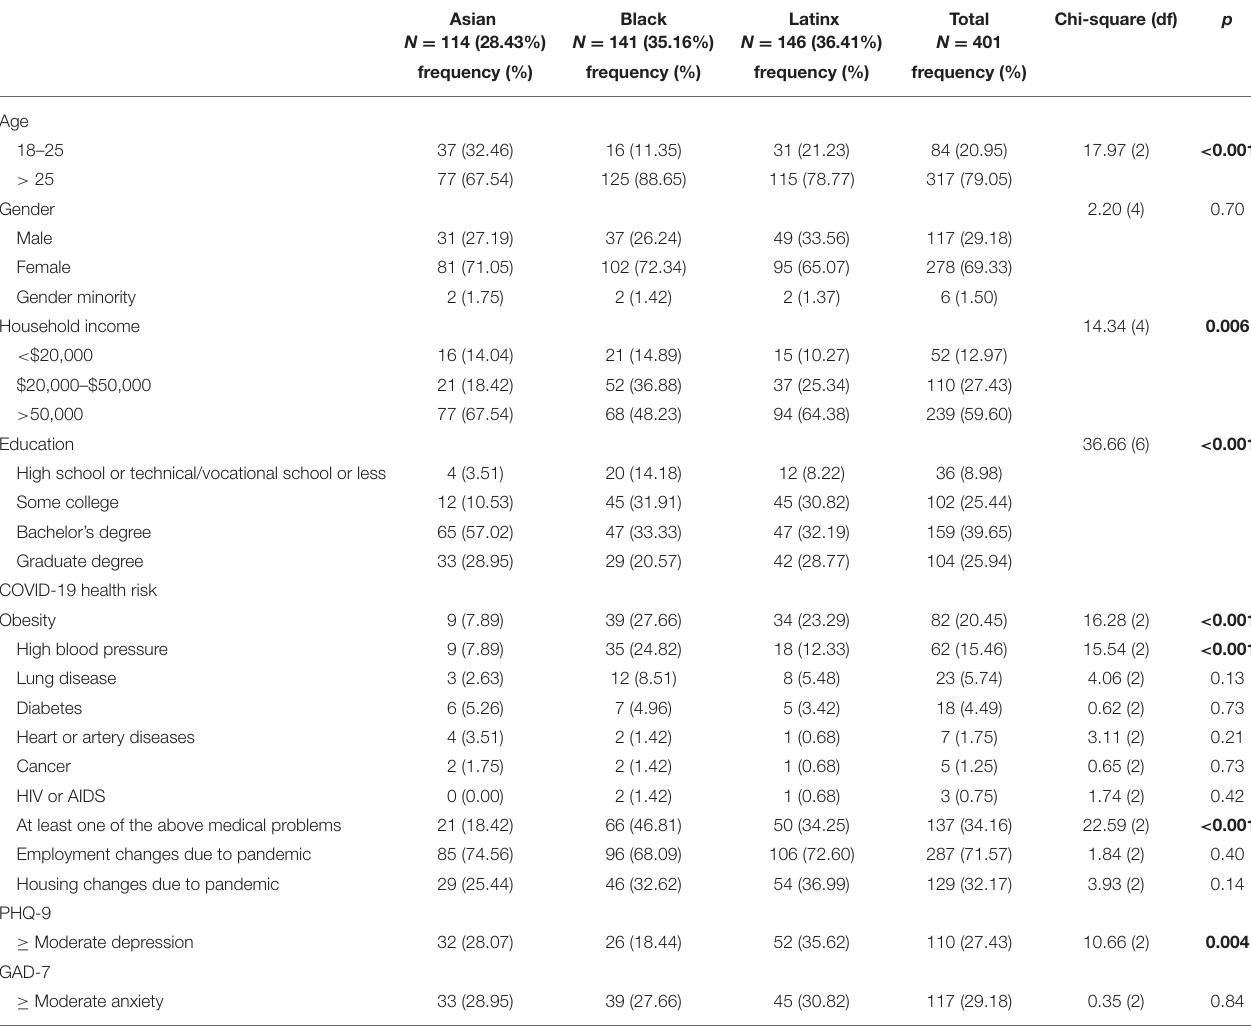
TABLE 1 | Demographics and COVID-related employment and health variables among Asian, black, and Latinx adults.